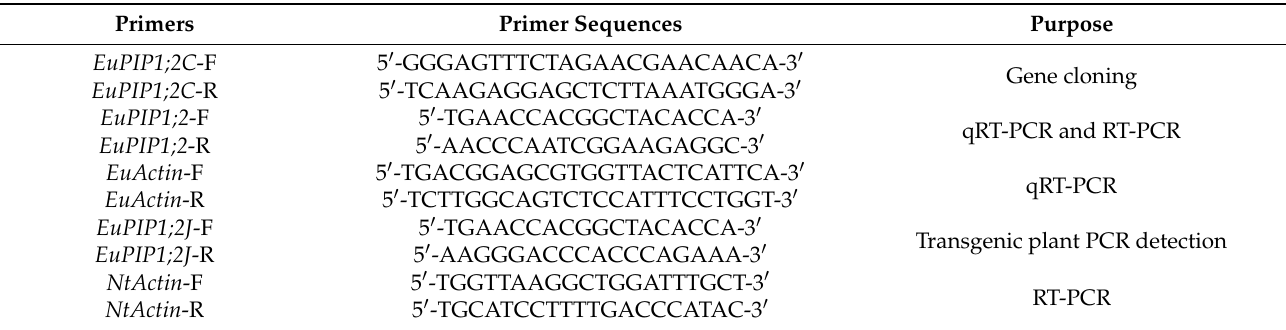
Table 1. Primers used in the study.